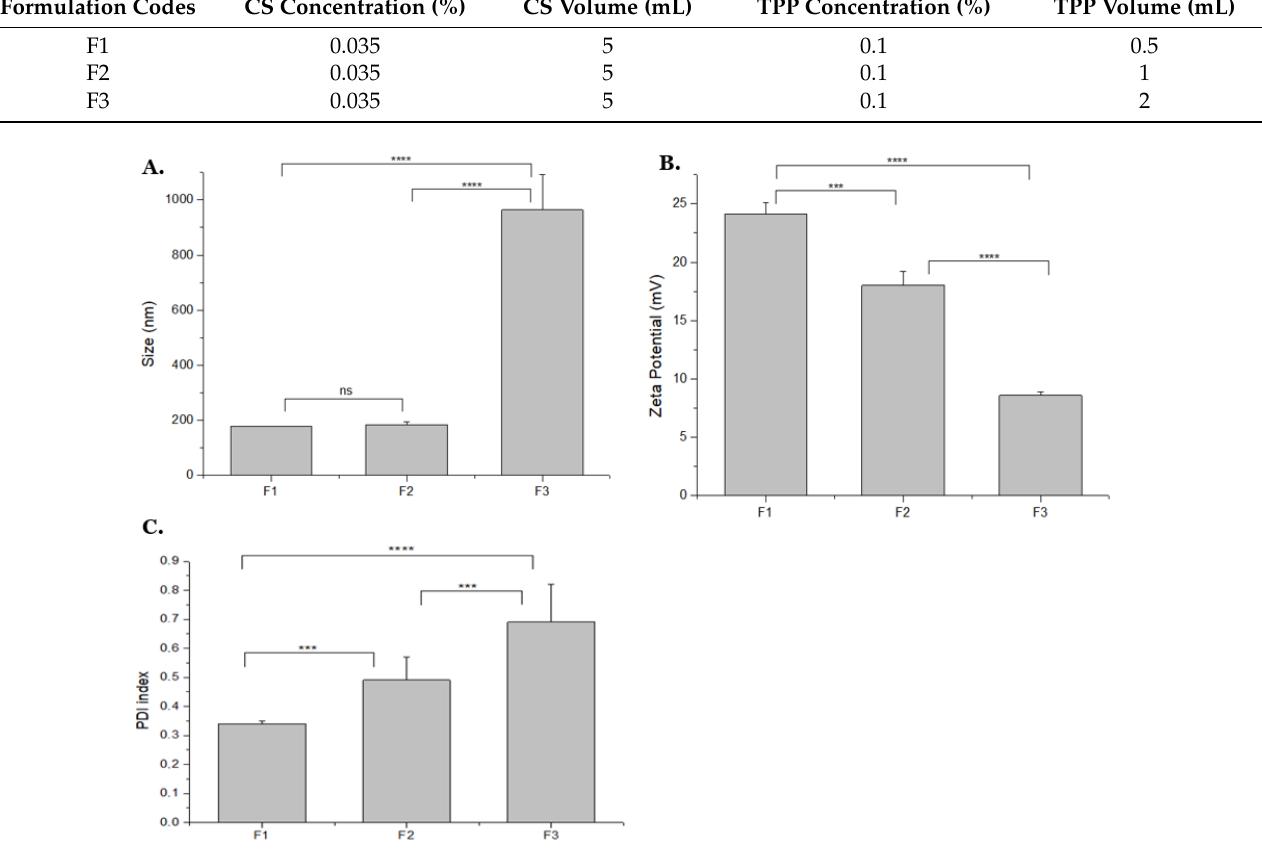
Figure 1. NPs ( A ) mean size (nm), ( B ) Average zeta potential, ( C ) PDI, obtained when different TPP volumes were added to formulations (F1 = 0.5; F2 = 1 and F3 = 2 mL). The values were calculated with the data obtained from three independent measurements (mean ± S.D., n = 3); *** p < 0.001; **** p < 0.0001, ns – not significant.